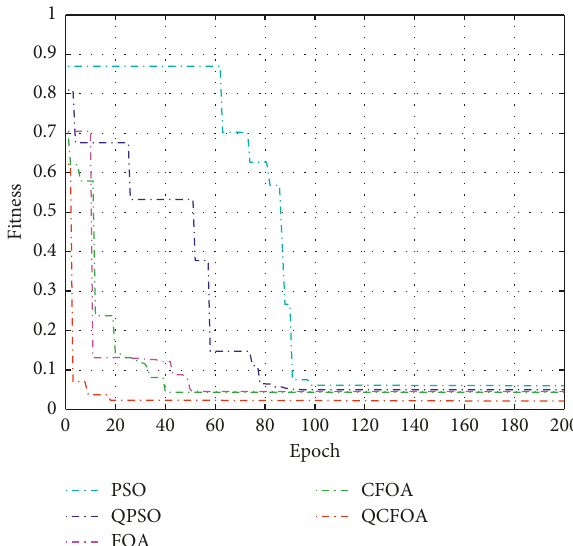
Figure 3: Search process diagram of three optimization algorithms.